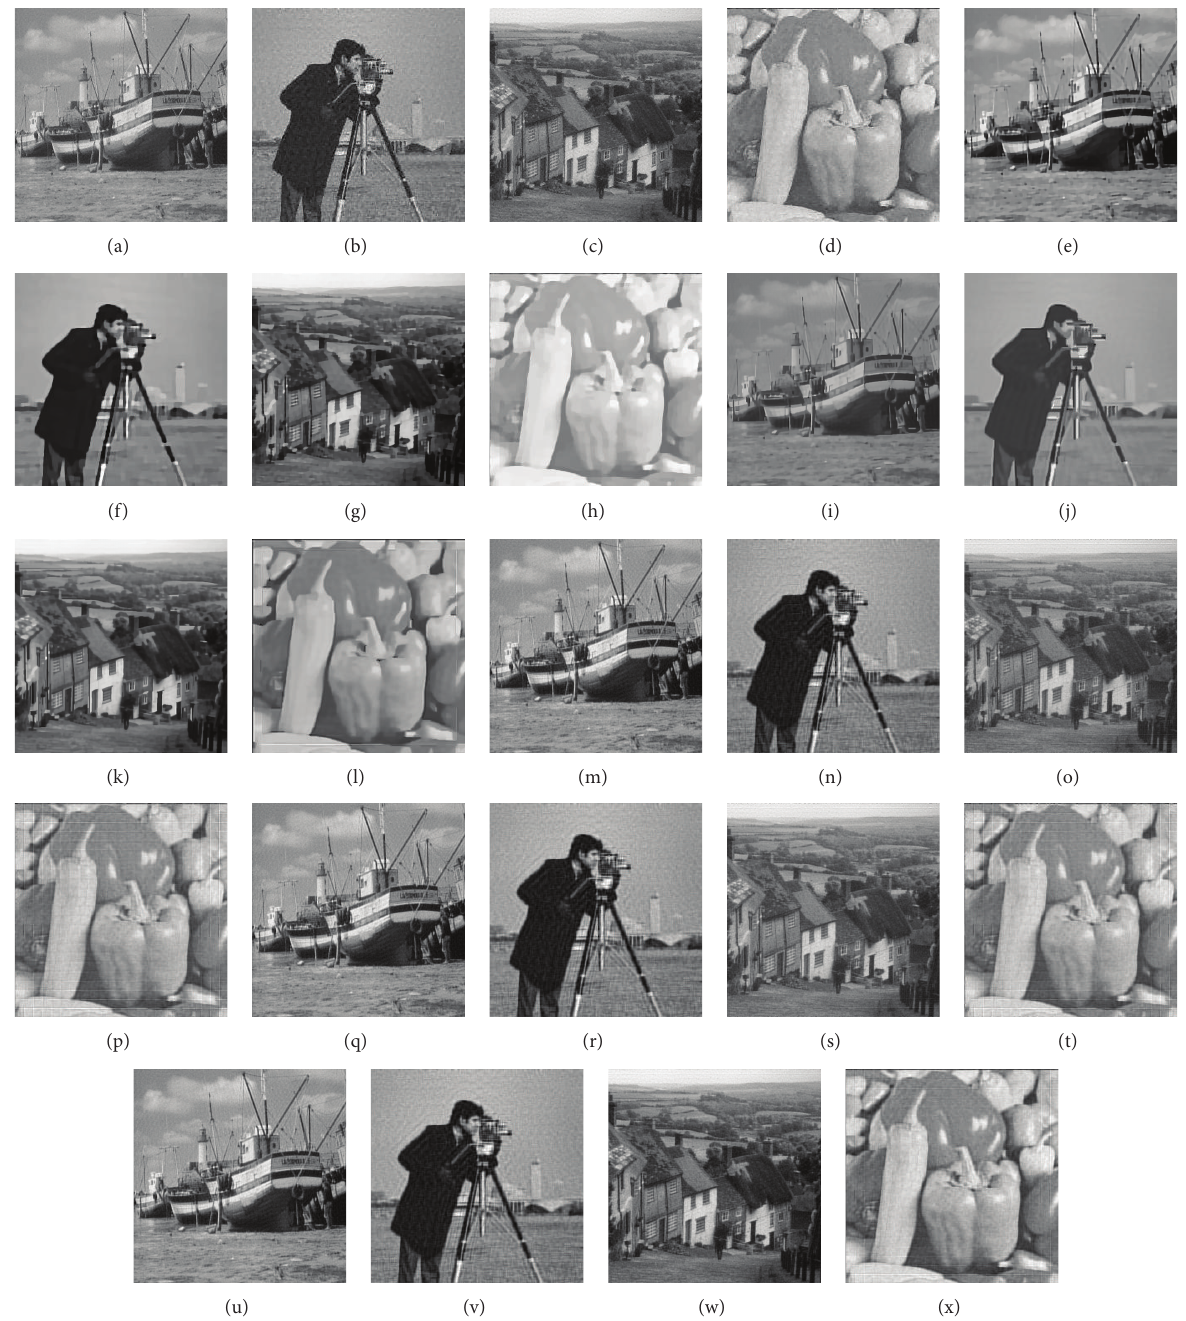
Figure 3: Restored Gaussian blurred-noisy images obtained by ((a)–(d)) DeblurSps, ((e)–(h)) TV BOS, ((i)–(l)) NLTV BOS, ((m)–(p)) SBMTV 1/4 , ((q)–(t)) SBMTV 1/3 , and ((u)–(x)) SBMTV 4/5